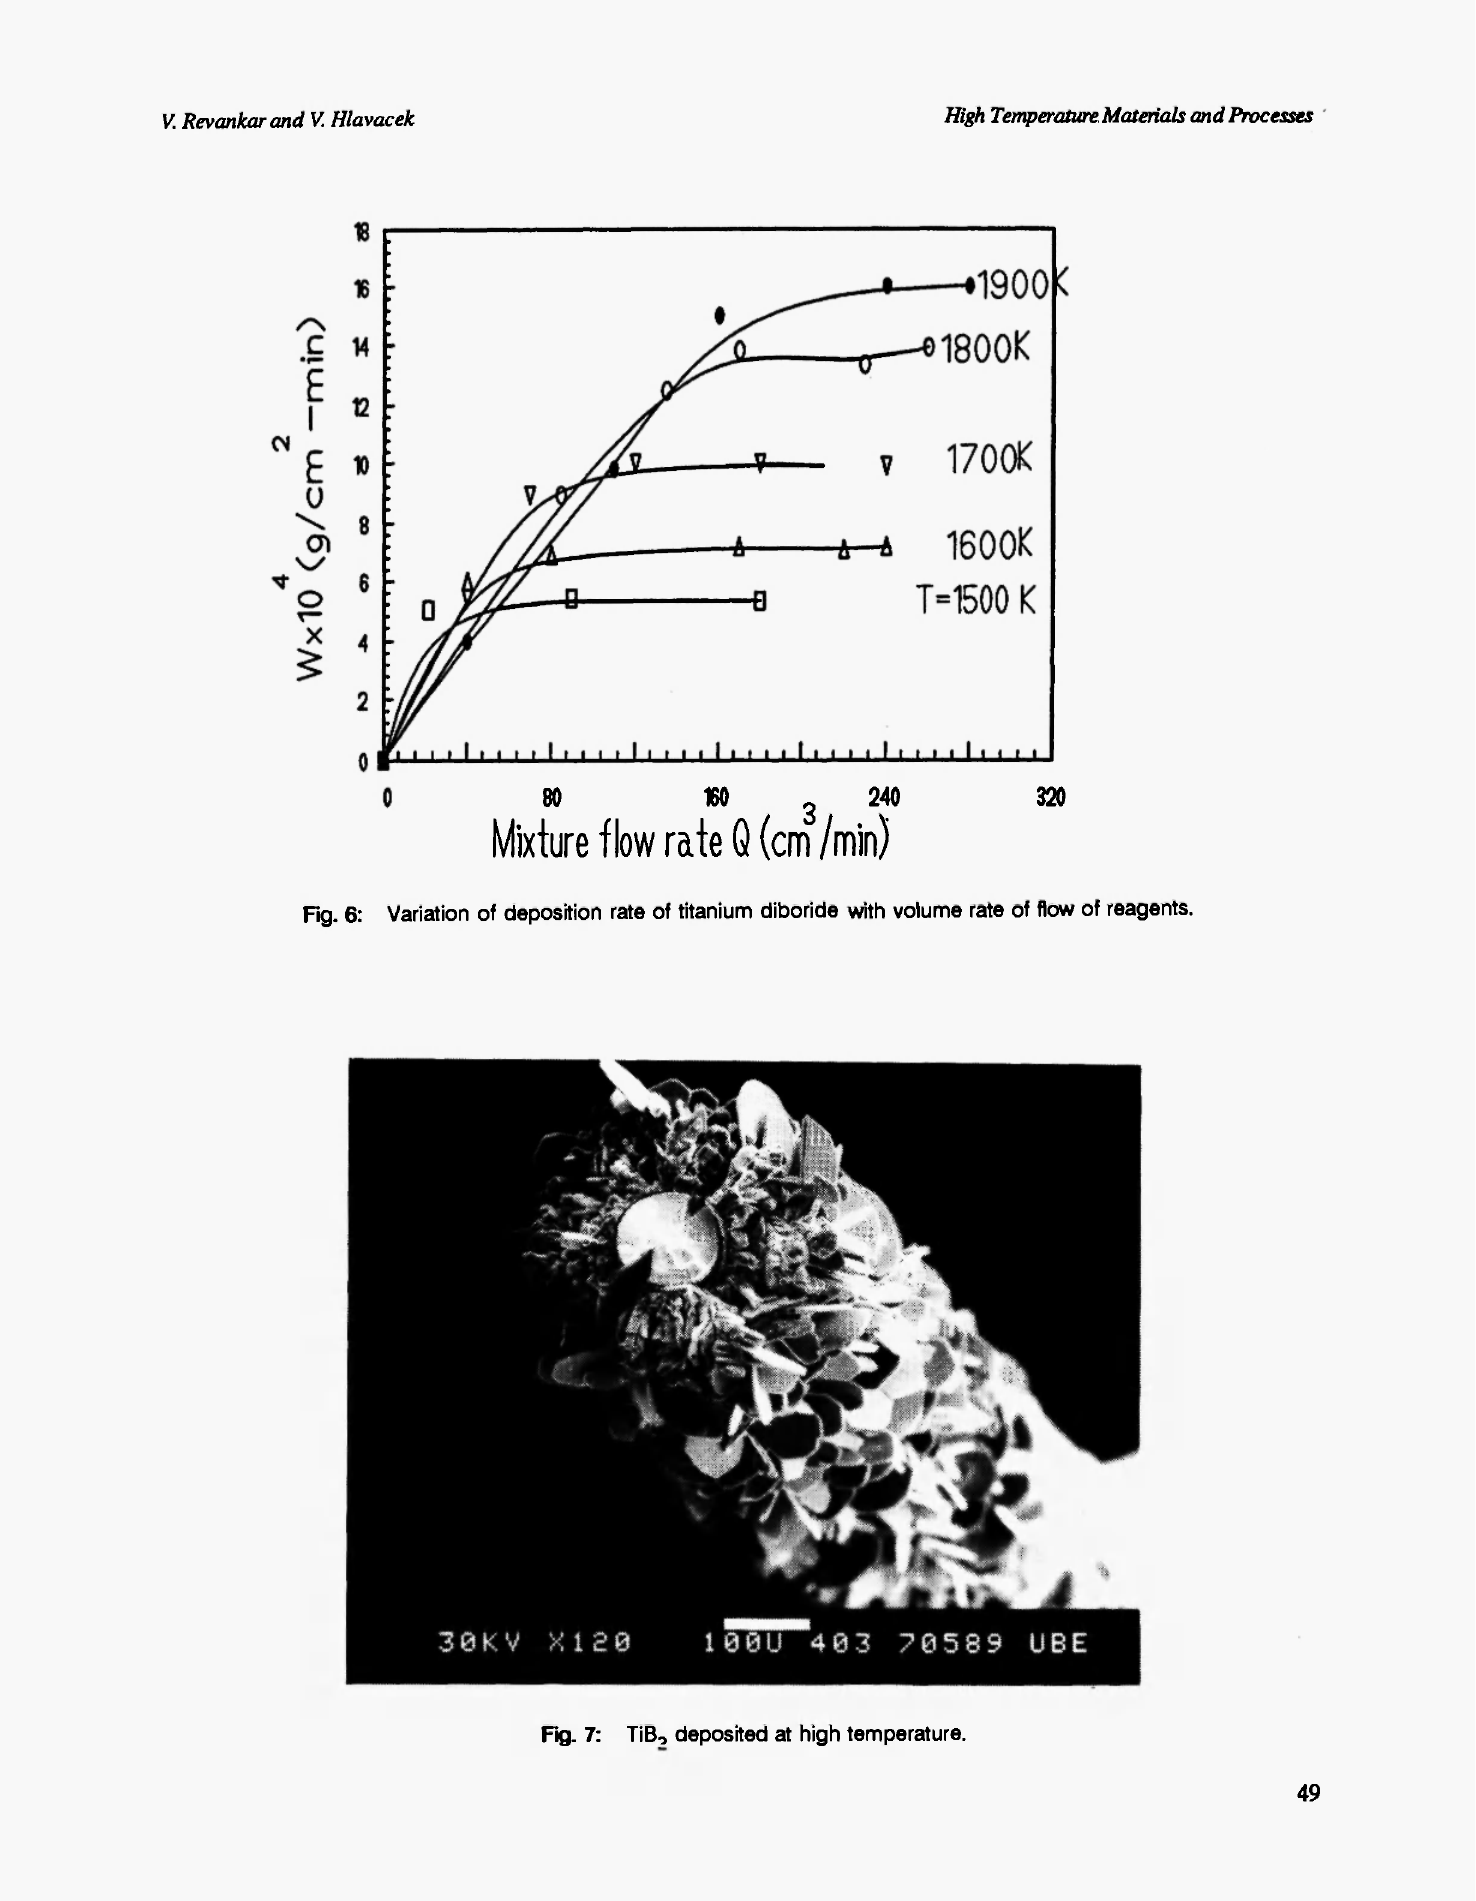
Fig. 7: TiB, deposited at high